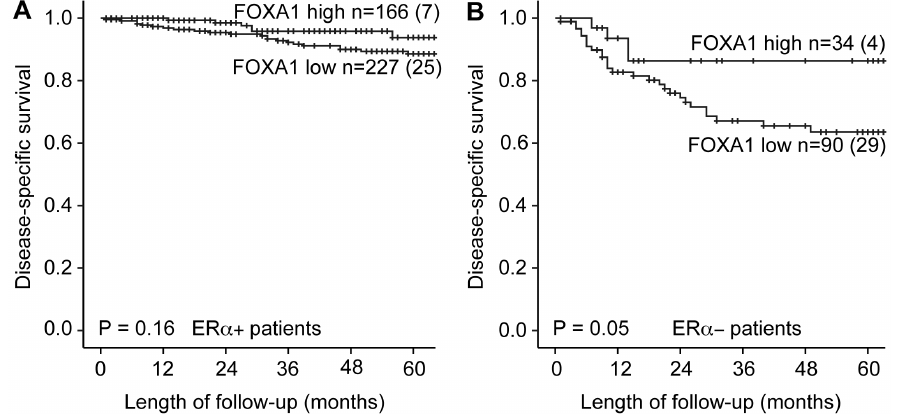
Figure 2. FOXA1 survival analyses stratified for ER a status in the tumors. (A) Low FOXA1 expression among ER a positive patients did not significantly impact survival. (B) Amongst ER a negative patients FOXA1 expression significantly influenced survival with worst prognosis for patients with low FOXA1.